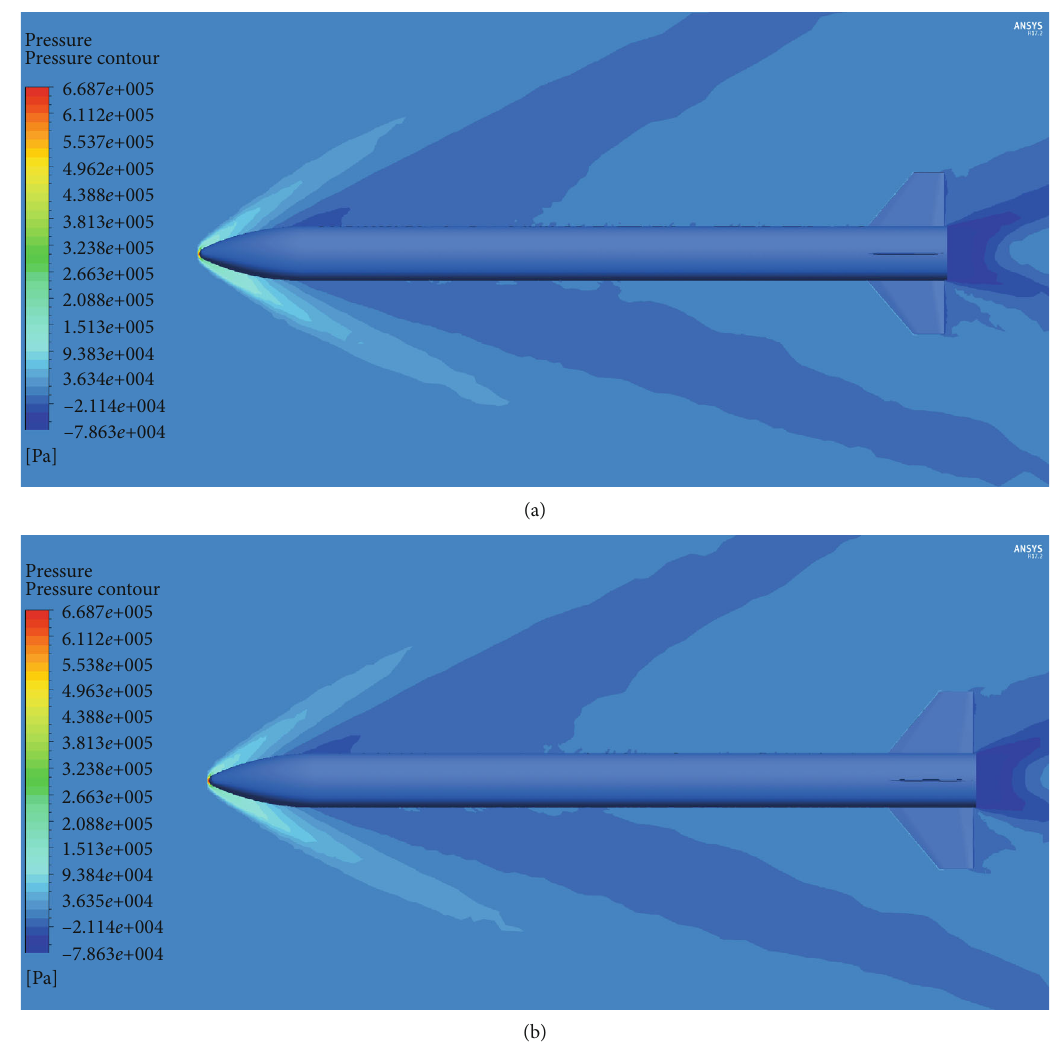
Figure 15: Comparison of the pressure contours of the optimum and baseline missile models at 2.5 Mach number and 4 ° AoA: (a) baseline model and (b) optimum